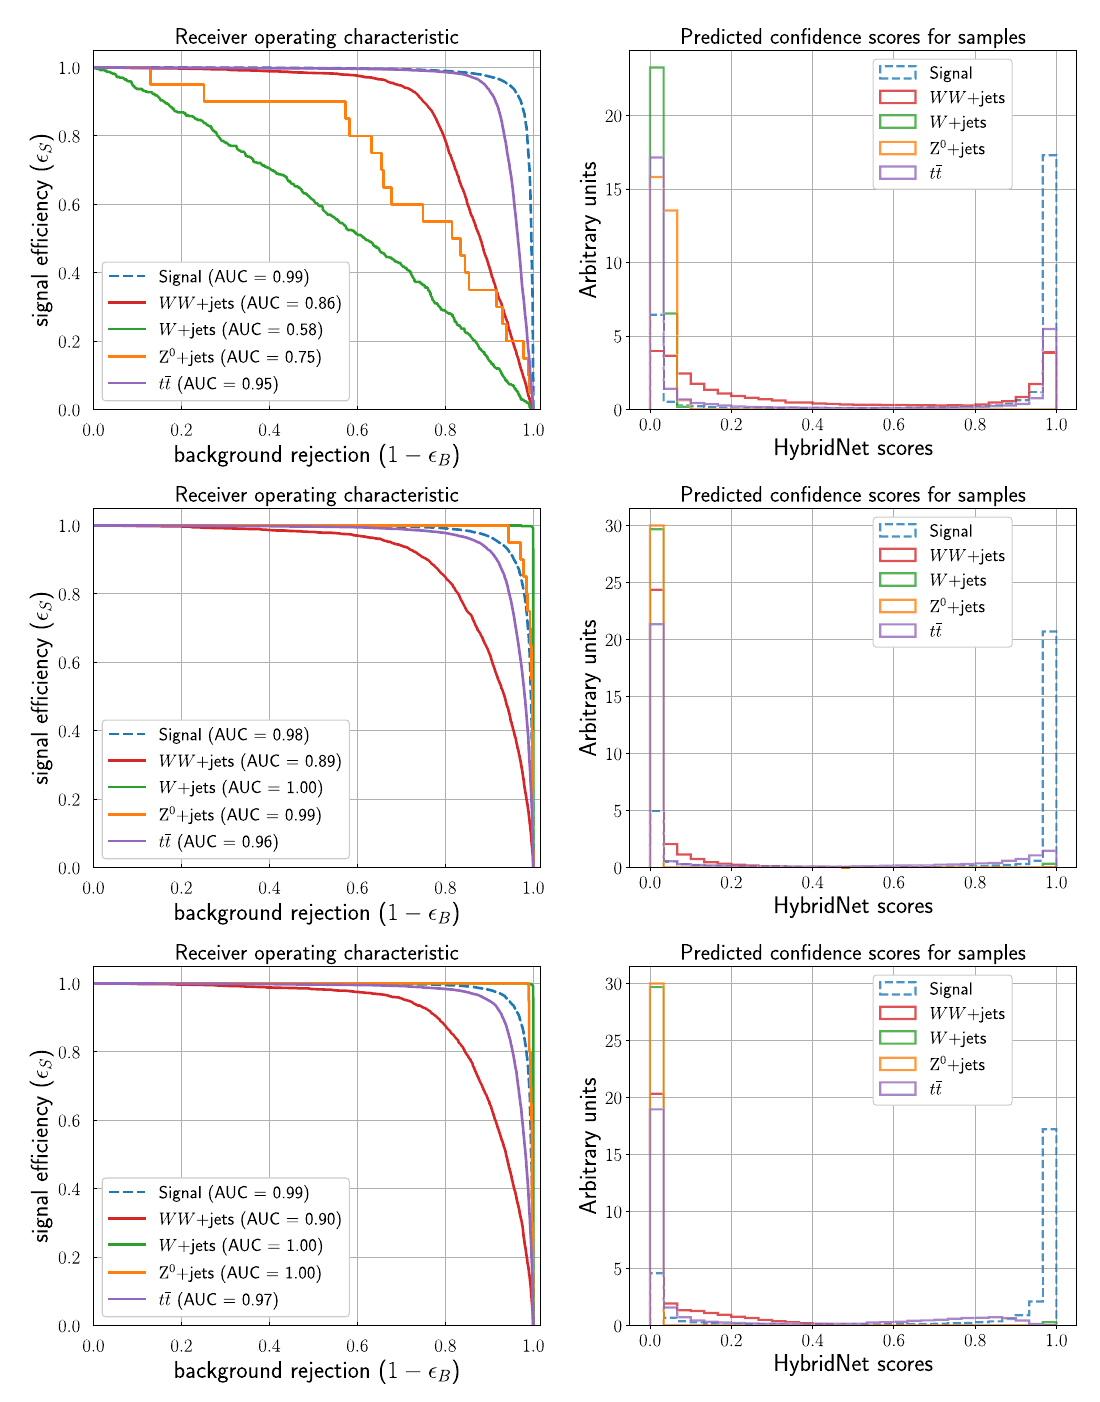
Fig. 4 Performance results for the Hybrid network. On each panel, we plot the ROC on the left-hand side and, on the right, – the prediced con- fidence score for our samples. In the top panel, the results are shown for classification with only kinematic data, in the middle panel we have